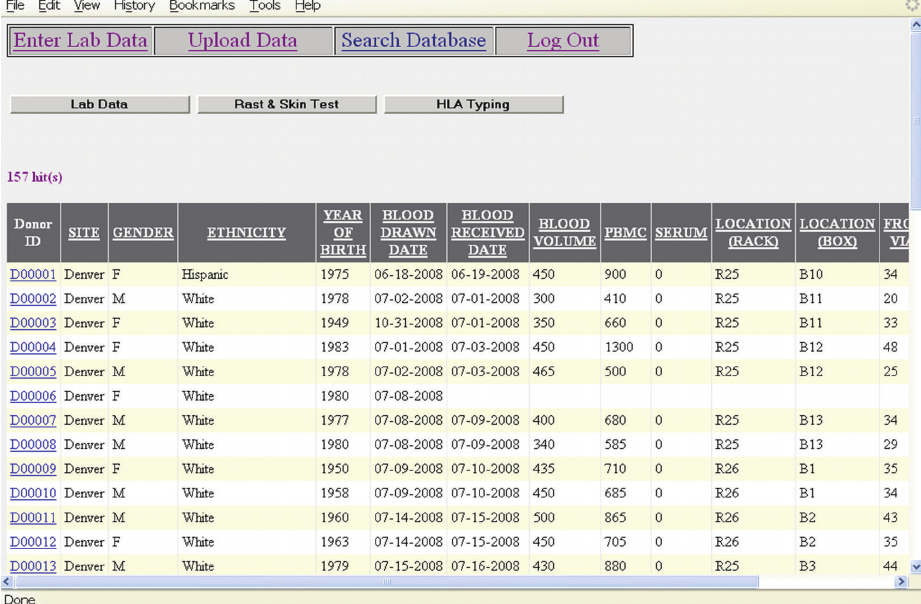
hold the tested peptides and which wells are used to hold the controls. The peptides used are specified in a separate file containing peptide